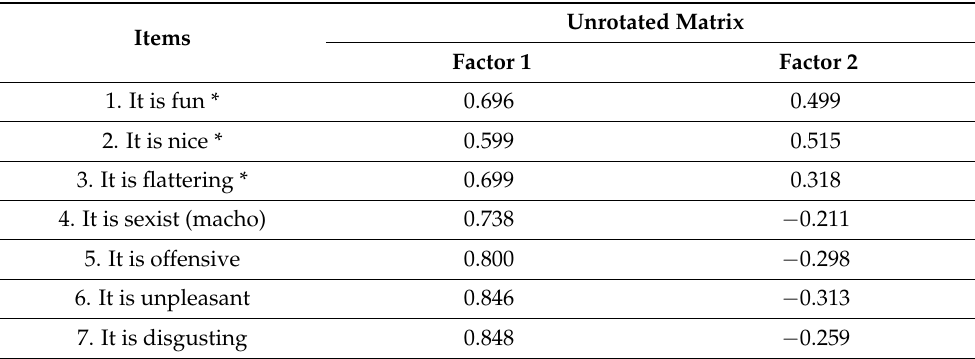
Table 3. Factor loadings of the Questionnaire on Attitudes towards